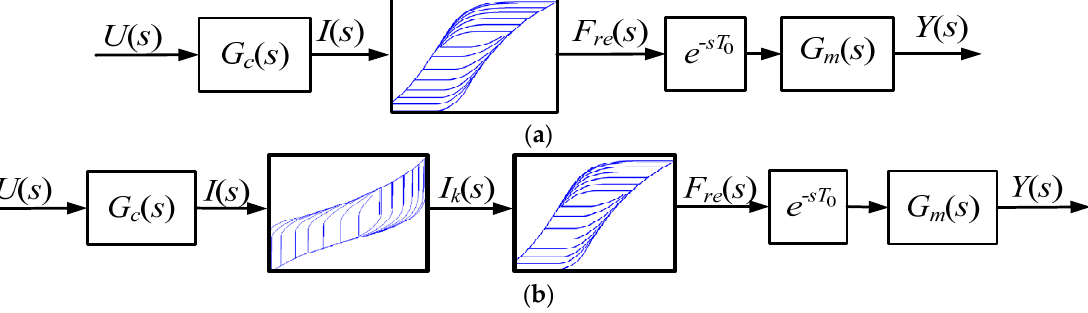
Figure 11. MSMA actuator model structure: ( a ) classical approach, ( b ) with hysteresis